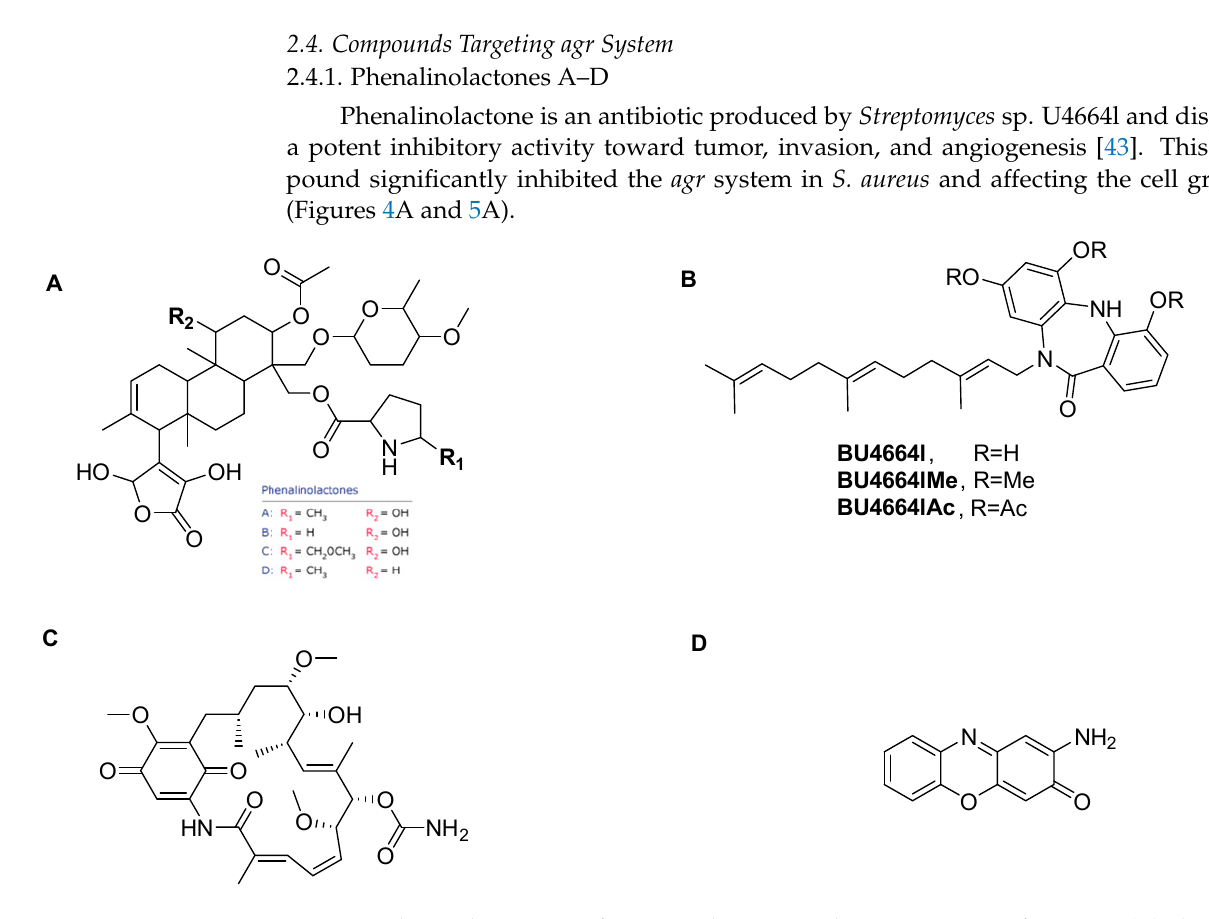
Figure 4. Chemical structures of compounds targeting the agr QS system of S. aureus . ( A ) Phenalino- lactones A–D, ( B ) BU–4664L, ( C ) Geldanamycin, ( D ) Questinomycin A.